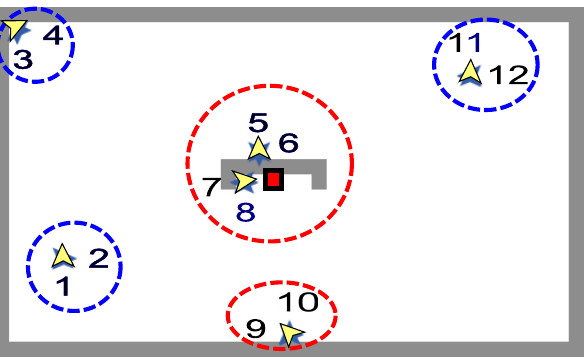
Figure 8. Learning cases are grouped into two sets according the evaluation to generalise using the test set, in blue are the cases with higher scores and, in red the cases with lower scores.